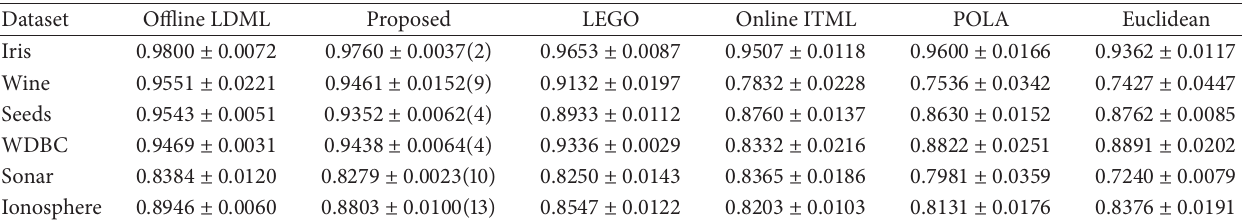
Table 2: Cross validation classification accuracy comparison with the state-of-the-art metric learning methods on the normal size data sets. Dataset Offline LDML Proposed LEGO